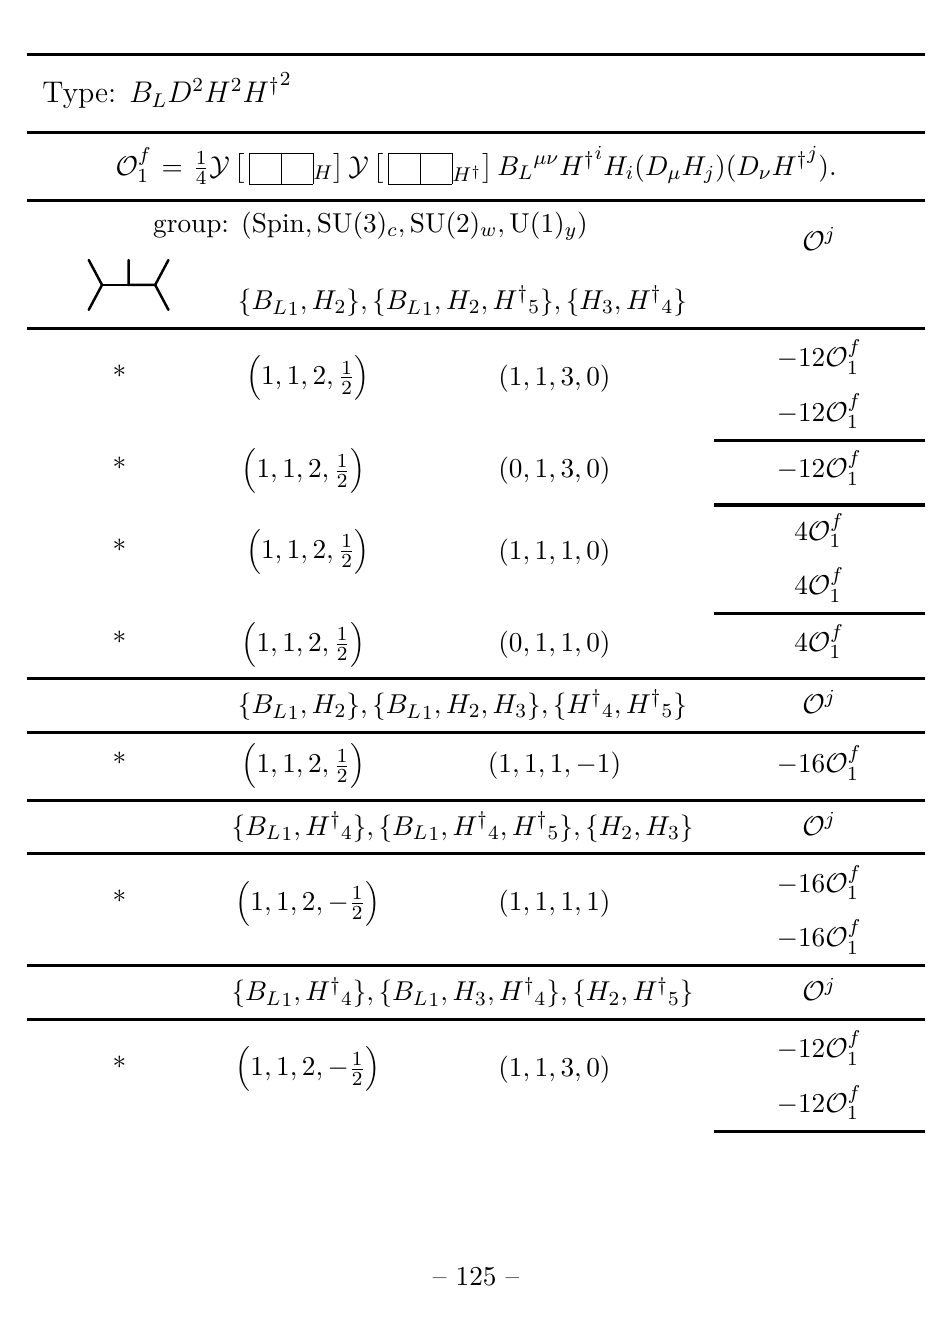
Table 28. UV resonance of topology dim8-bosonic-4. “*” in front of each row indicates topologies with nonrenormalizable